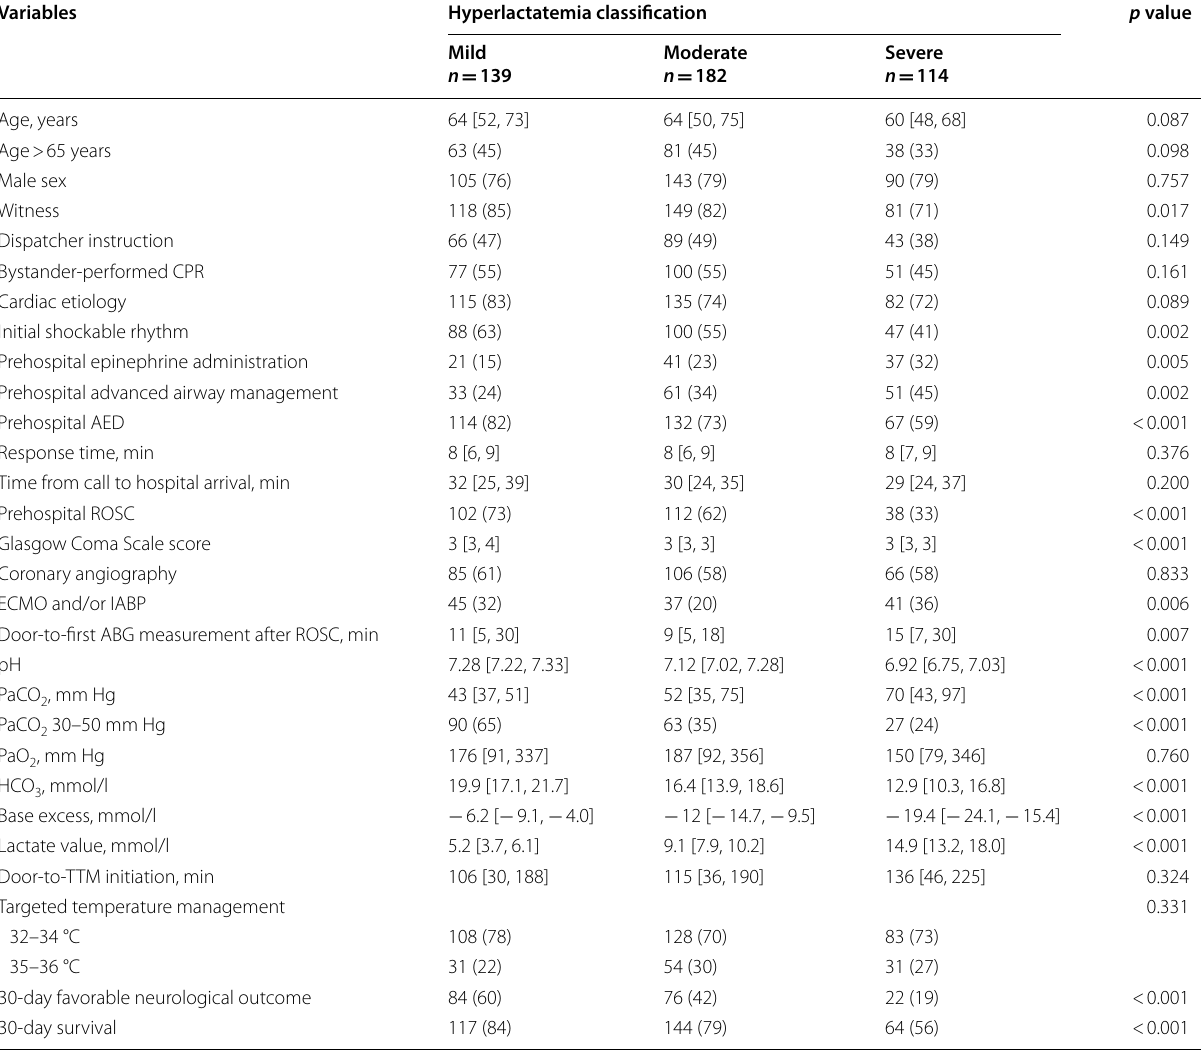
Continuous variables were presented as median [Interquartile range]. Categorical variables were presented as n (%) CPR cardiopulmonary resuscitation, AED automated external defibrillator, ROSC return of spontaneous circulation, ECMO extracorporeal membrane oxygenation, IABP intra-aortic balloon pumping, ABG arterial blood gas